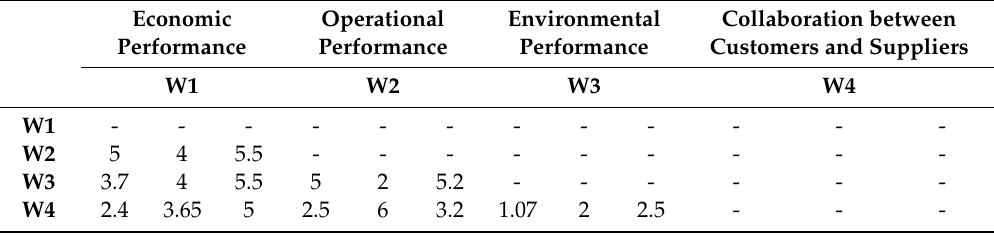
Table 12. Paired comparison matrix of KPIs in the FMCG industry green supply chain, based on integration of experts in strategic section.